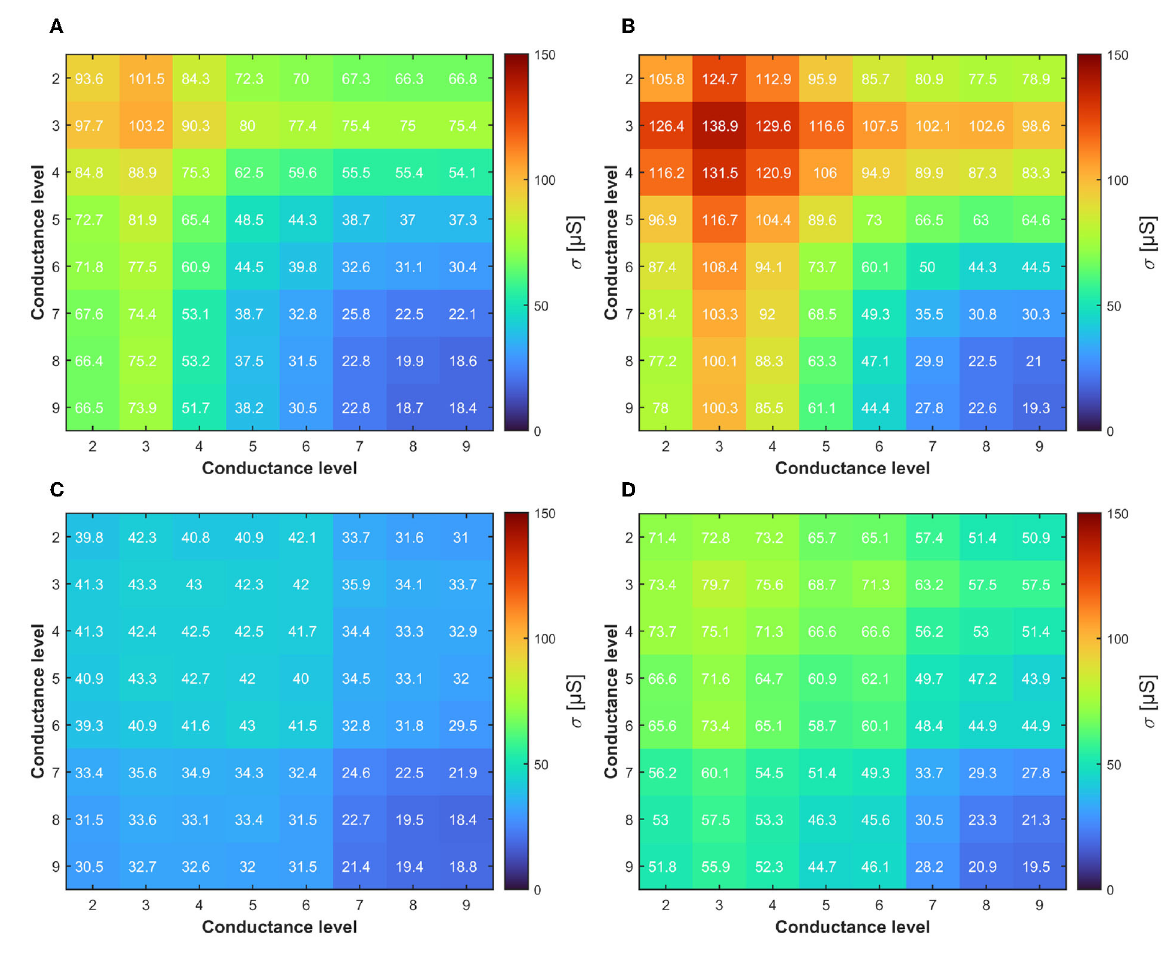
FIGURE6 (A) Colormap of the conductance σ of the differential distribution obtained through ML-Set at the end of the programming algorithm. (B) and after 168 h evidencing the effect of the drift. (C,D) Same analysis performed for ML-Hybrid. The lower is better for DeepSurv